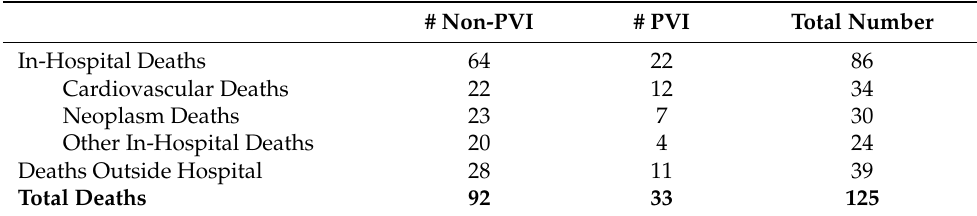
Table 4. Number of